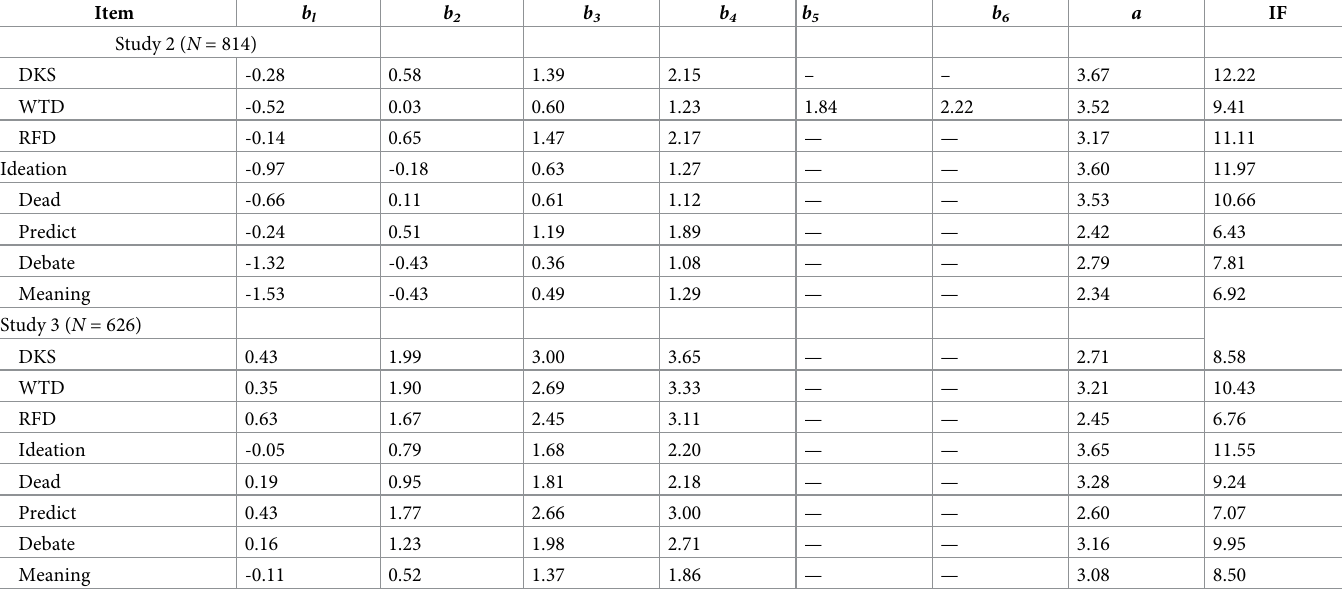
Table 7. Graded response model analyses of Suicidality Scale items, studies 2 and